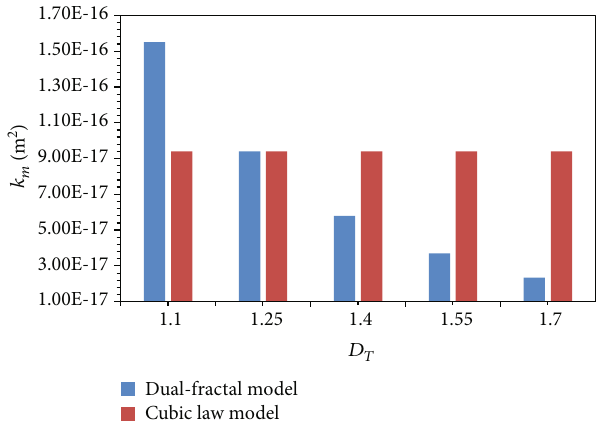
Figure 18: Permeability evolution under di ff erent fractal dimension of throat